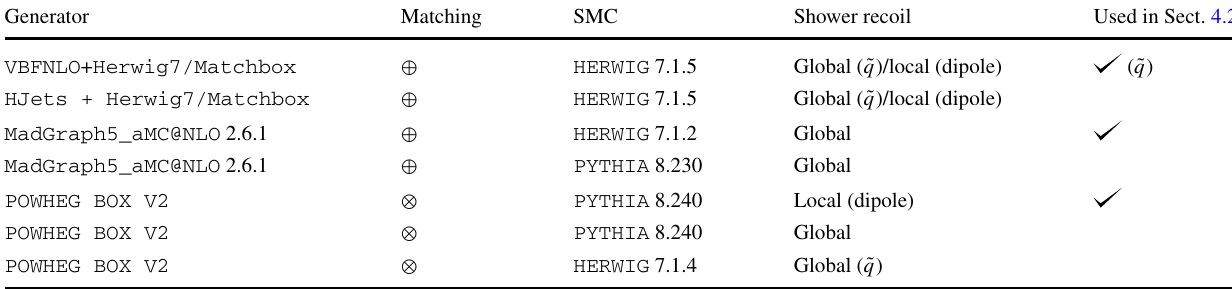
Table 1 The various generators used in the comparisons throughout this paper and their respective settings Generator Matching SMC Shower recoil Used in Sect. 4.2 VBFNLO + Herwig7/Matchbox ⊕ HERWIG 7.1.5 Global ( ˜ q )/local (dipole) ( ˜ q ) HJets + Herwig7/Matchbox ⊕ HERWIG 7.1.5 Global ( ˜ q )/local (dipole) ⊕ HERWIG 7.1.2 Global PYTHIA 8.230 Global PYTHIA 8.240 Local (dipole) PYTHIA 8.240 HERWIG 7.1.4 Global ( ˜ q